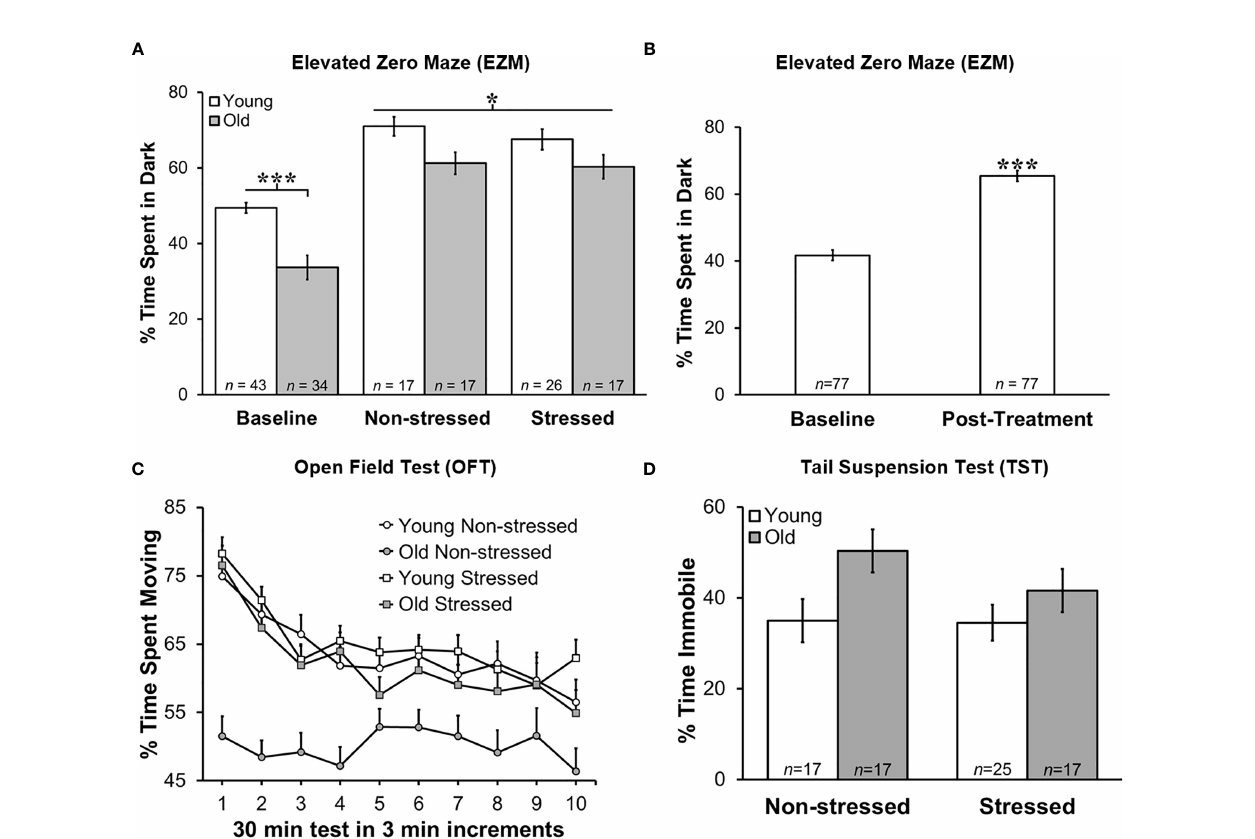
FIGURE 3 | Greater Anxiety-like Behavior in Young Mice in Zero Maze, and Post-treatment than at Baseline, but No Difference in Time Immobile on Tail Suspension Test. Behavioral effects of restraint stress and isolation in young and old tumor-bearing C57BL/6 mice. (A) Young mice spent signi fi cantly more time in the dark post- tumor inoculation compared with old mice ( p <0.0001). Stress did not signi fi cantly alter the time spent in the dark for either young or old mice. Young mice spent signi fi cantly more time in the dark compared with old mice overall ( p <0.0001). (B) When groups were collapsed, all mice spent signi fi cantly more time in the dark post-treatment compared with baseline ( p <0.0001). Data are expressed as the mean % of time spent in the dark ± S.E.M. (C) Old non-stressed mice were signi fi cantly less active throughout the test compared with old stressed mice ( p <0.05) and with young mice regardless of being stressed or non-stressed ( p< 0.05). Data are expressed as the mean % spent moving ± S.E.M. for each treatment group for each 3 min increment over the 30 min time period for the OFT ( n =17-26 mice per group). (D) There were no group differences in percent time immobile on TST. * p < 0.05, *** p <